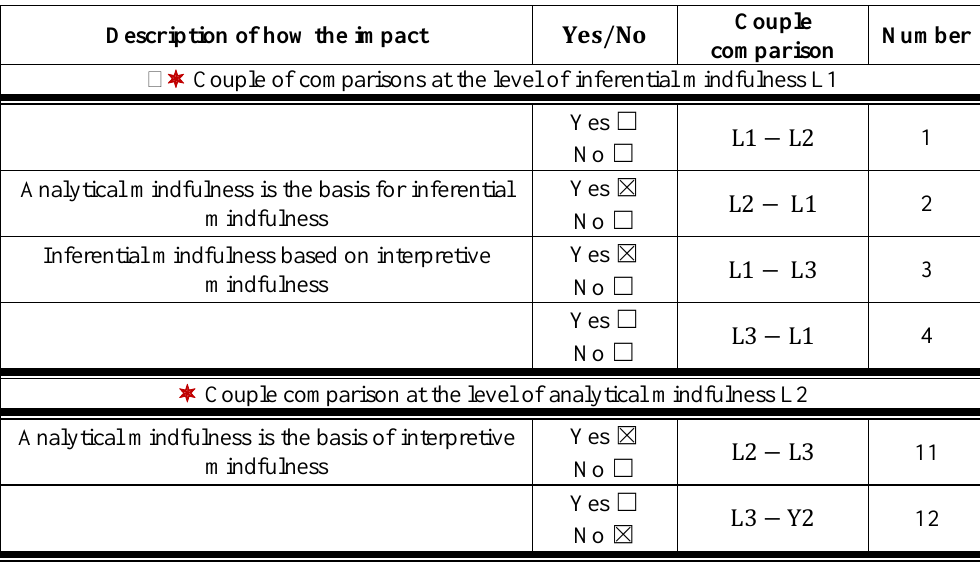
Couple Number comparison